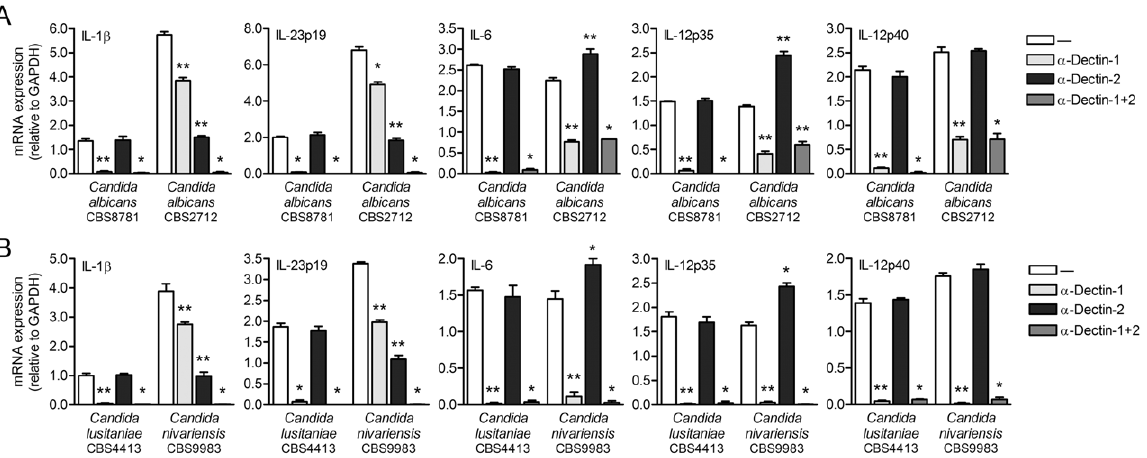
Figure 5. Dectin-1 and dectin-2 contribute to Candida spp.-induced cytokine expression. (A and B) Quantitative real-time PCR for indicated mRNAs in DCs stimulated with Candida albicans spp. (A), C. nivariensis or C. lusitaniae (B) in the absence or presence of blocking antibodies against dectin-1 and/or dectin-2. Expression is normalized to GAPDH and set at 1 in curdlan-stimulated cells. Data are mean 6 s.d. of four independent experiments, * p , 0.05 and ** p , 0.01 (Student’s t